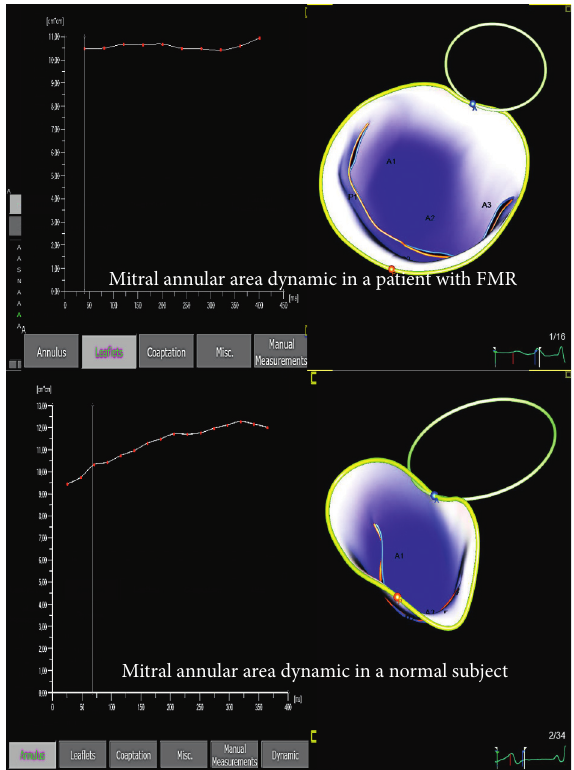
Figure 3: Mitral annular area change by 3D transthoracic echo- cardiography throughout the cardiac systole, in a patient with functional mitral regurgitation (upper panel) and a normal subject (lower panel); mitral annulus from the patient with functional mitral regurgitation is dilated, spherical and shows smaller changes in the annular area during the cardiac systole than the normal mitral